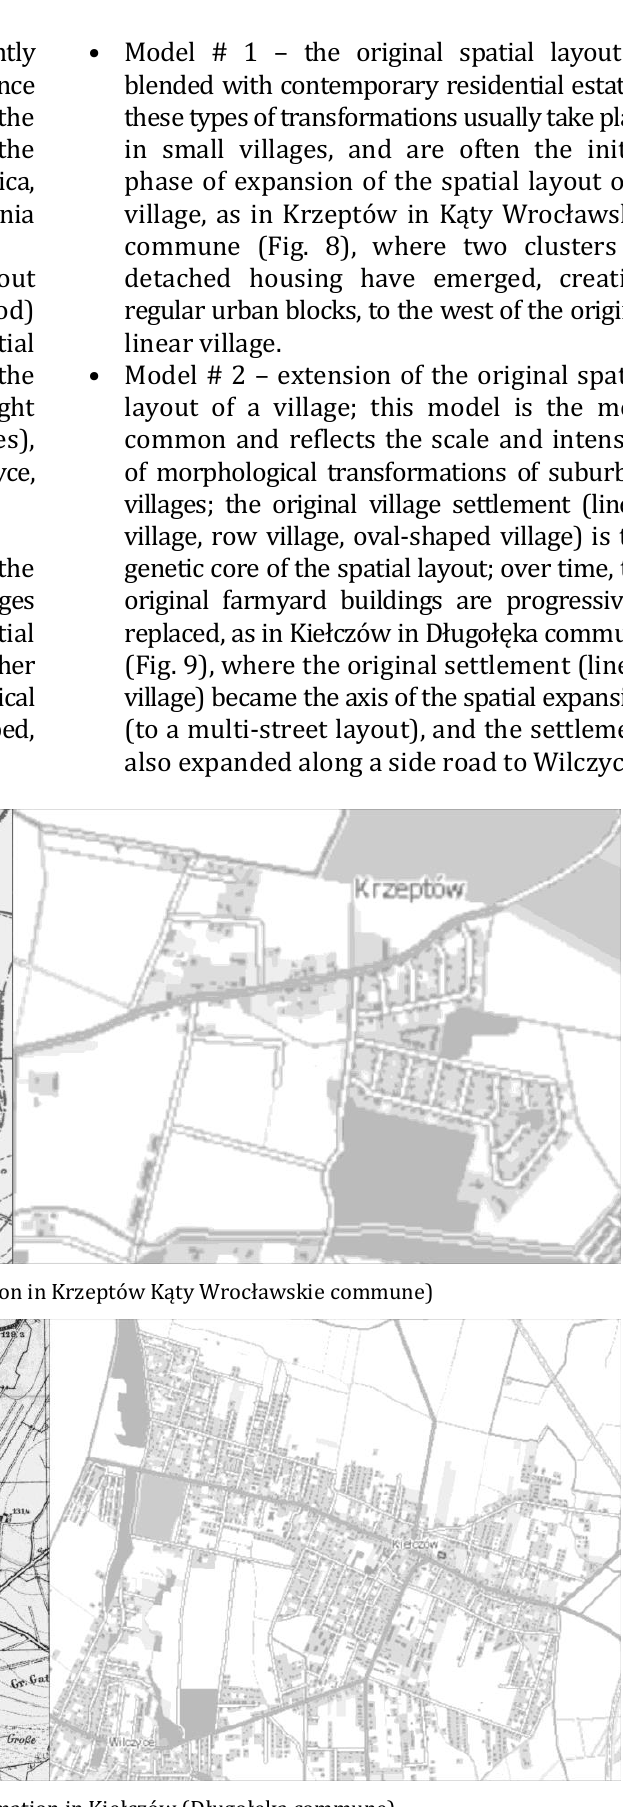
Fig. 9. Morphological transformation in Kiełczów (Długołęka